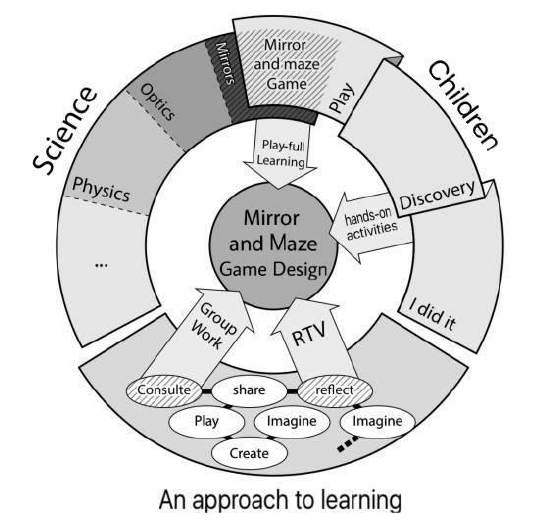
Figure 2 The kindergarten approach to learning (Mitchel R., 2007) Figure 3 Maze and Mirror Game